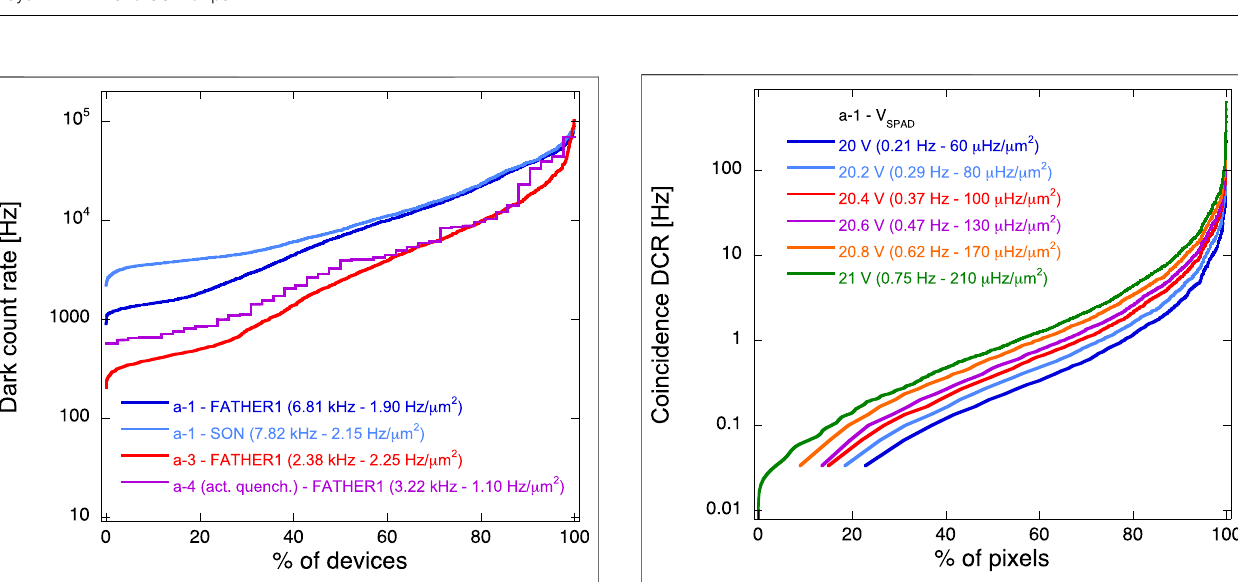
FIGURE9 | Breakdown voltage distribution for pixels from three a -1structures( fi gures (A) , (B) ) and for pixels from a -3and a -4structures( fi gures (C) , (D) ) in single- layer FATHER and SON chips.